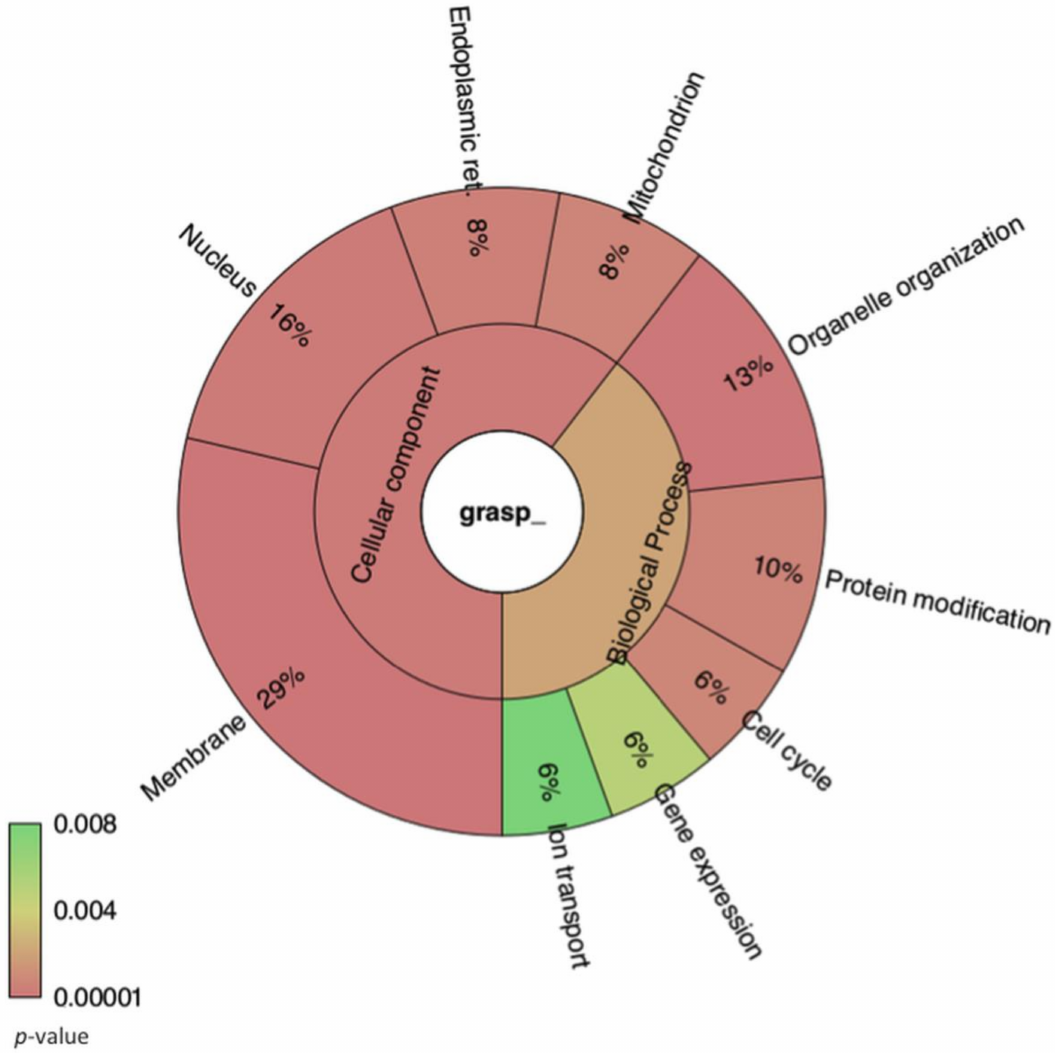
Figure 3. Krona chart representing the gene ontology of mRNA sequences enriched in EVs isolated from the C. neoformans grasp ∆ mutant. The percentage refers to the relative enrichment for the Gene Ontology (GO) terms. The colors represent the p -value for each term plotted in the